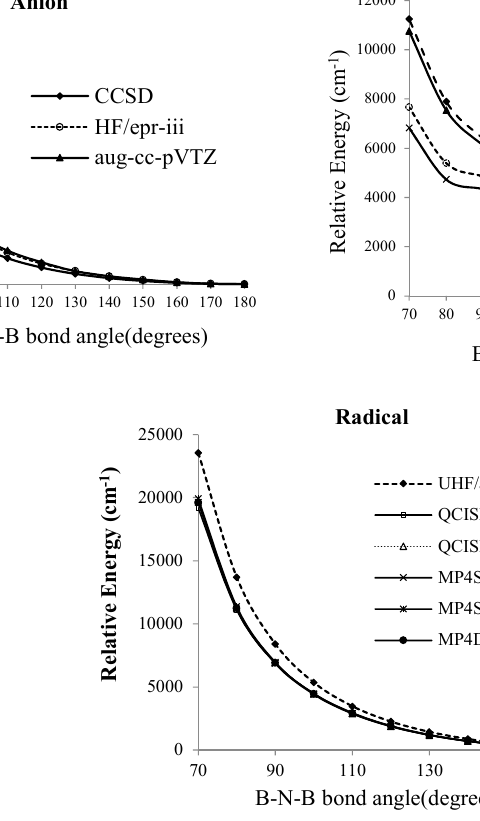
Figure 2. Relative energies of B 2 N ( − , 0, +) vs. B-N-B bond angle in various level of methods for anion, cation and radical forms of BNB respectively